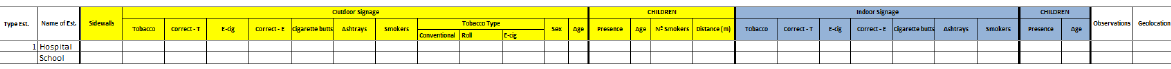
Figure A1. Tobacco worksheet for data collection.